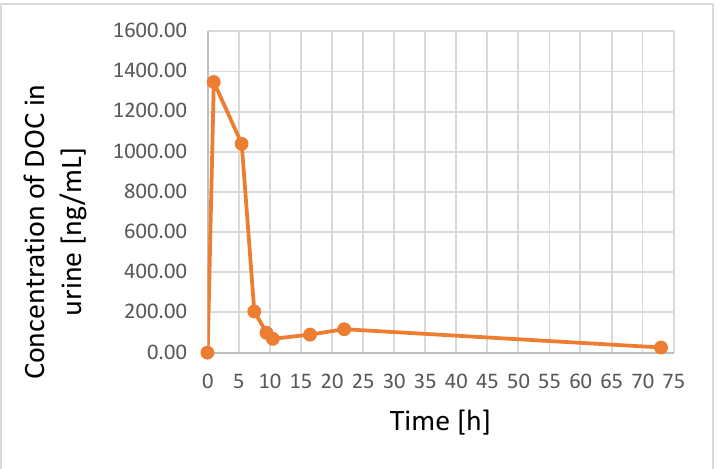
Figure 3. DOC concentration profiles in time intervals for urine samples from a 12-year-old cardiac AS patient after a 1 h IV infusion of DOC at a dose of 45 mg (30 mg/m 2 ).